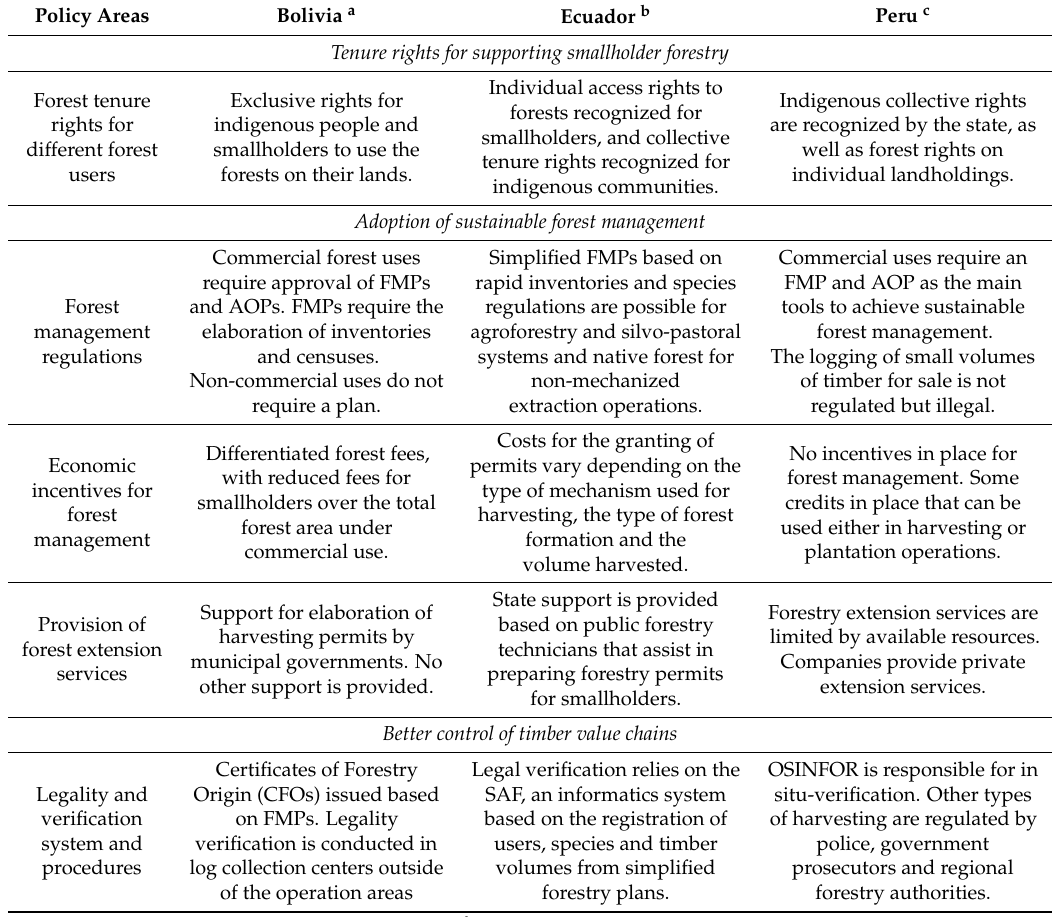
Table 2. Main Forest Policy Goals and Regulations in Bolivia, Ecuador and